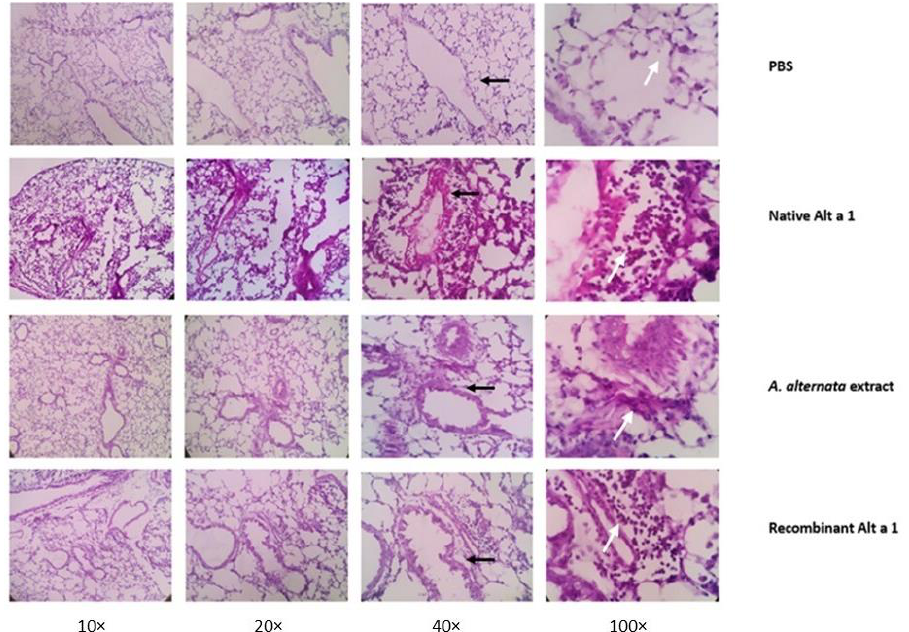
Figure 7. Images of lung histological sections performed on each group of animals (PBS, nAlt a 1, A.alternata Extract and rAlt a 1). Lungs were collected 24 h after the last instillation and formalin-fixed and stained with H&E. The black arrows point to the thickened peribronchial tissue in the lungs of the different groups of mice while the white arrows point to the eosinophils present in the epithelial lung tissue of the mice instilled with the control and Alt a 1 solutions.